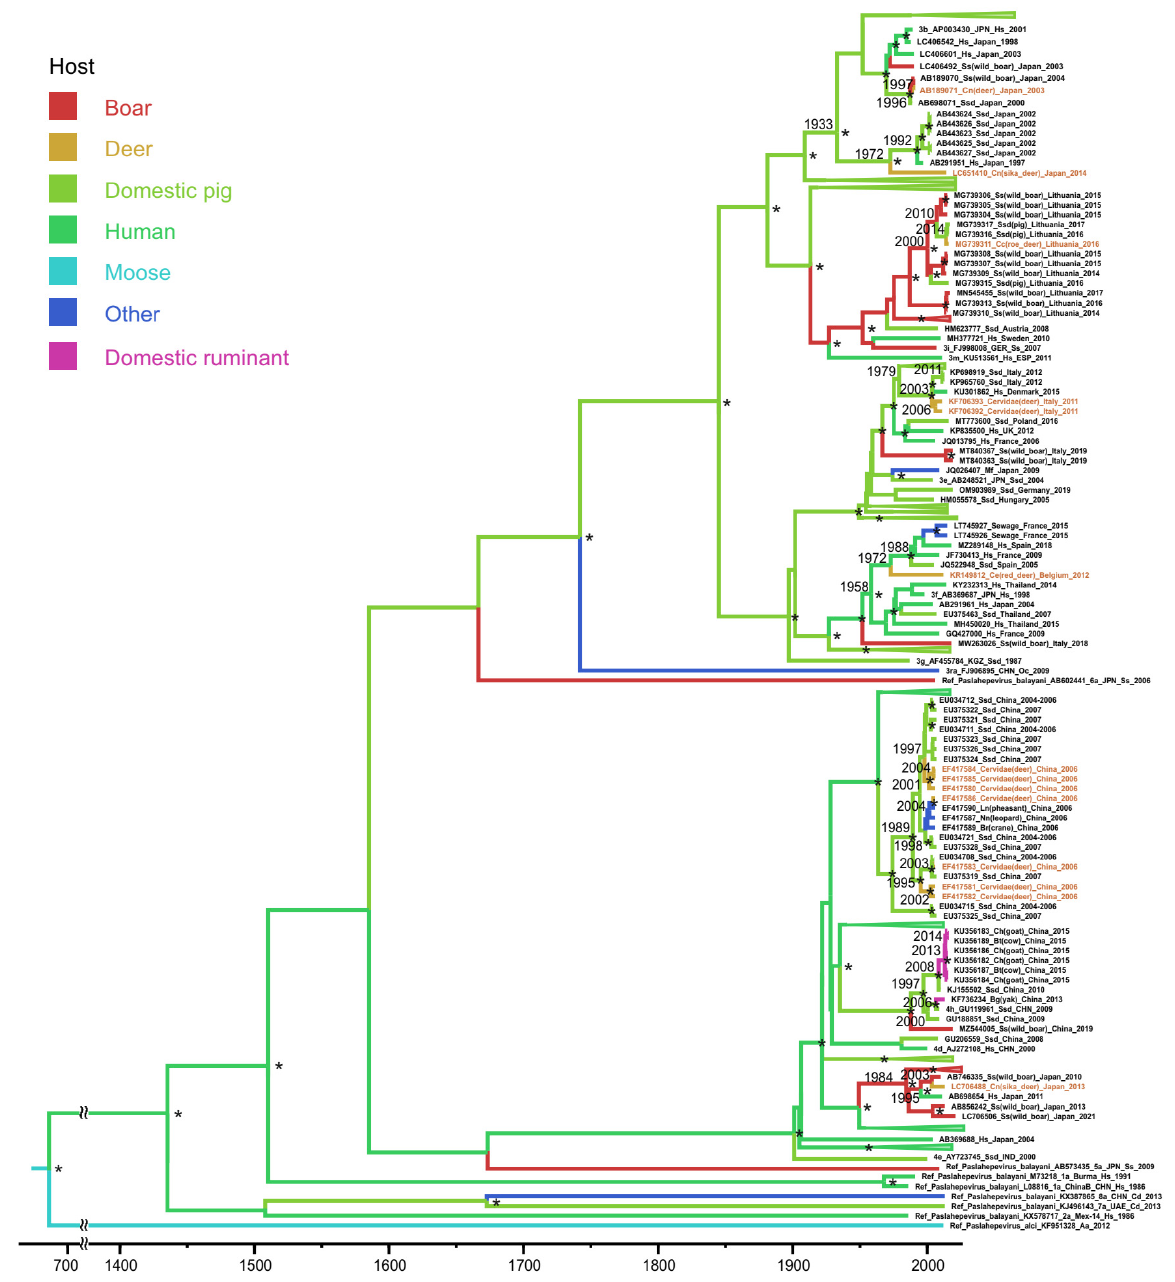
Figure 2. Bayesian phylogenetic tree based on 344 nucleotide ORF2 HEV sequences with indicated host range. The tree root was cut off to ensure the visibility of the modern parts of the tree. For each sequence, the number in the GenBank database, country (region), host organism, and the year of isolation are indicated. Host designations are as follows: Hs—human ( Homo sapiens ), Ssd—domestic pig ( Sus scrofa domesticus ), Ss—wild boar ( Sus scrofa ), Cn—sika deer ( Cervus nippon ), Cc—roe deer ( Capreolus capreolus ), Cervidae—deer ( Cervidae sp.), Mf—monkey ( Macaca fuscata ), Ce—red deer ( Cervus elaphus ), Oc—rabbit ( Oryctolagus cuniculus ), Ln—pheasant ( Lophura nycthemera ), Nn—leopard ( Neofelis nebulosa ), Br—crane ( Balearica regulorum ), Bt—cow ( Bos taurus ), Ch—goat ( Capra hircus ), Bg—yak ( Bos grunniens ), Cd—camel ( Camelus sp.), and Aa—moose ( Alces alces ). The sequence names from the samples collected from deer are shown in brown. Tree nodes with posterior probabilities >90% are marked “*”. For key nodes, the calculated years of formation are indicated. The X axis shows chronological time expressed in years.